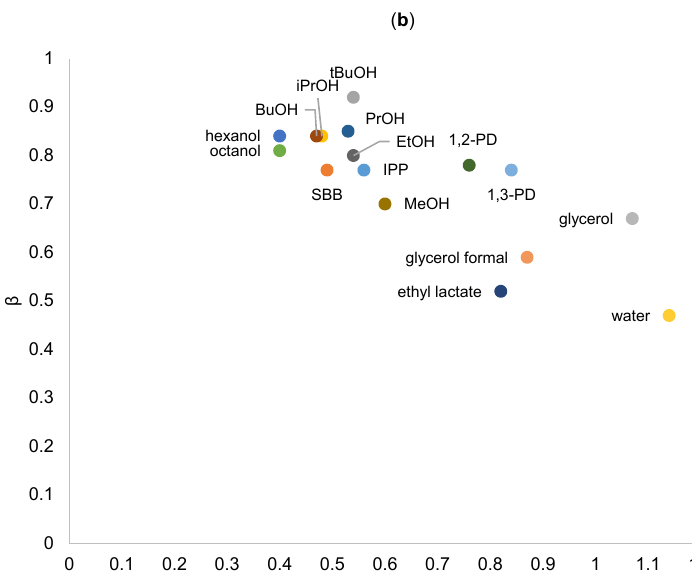
Figure 3. The positioning of the 1,2-PD and 2,3-BD derivatives on the β vs π * plots for aprotic ( a ) and protic ( b ) organic green solvents. The solvatochromic parameters for the rest of the compounds have been taken from the Ref. [60]. PEG—polyethylene glycol, GVL— γ -valerolactone, PPG—polypropylene